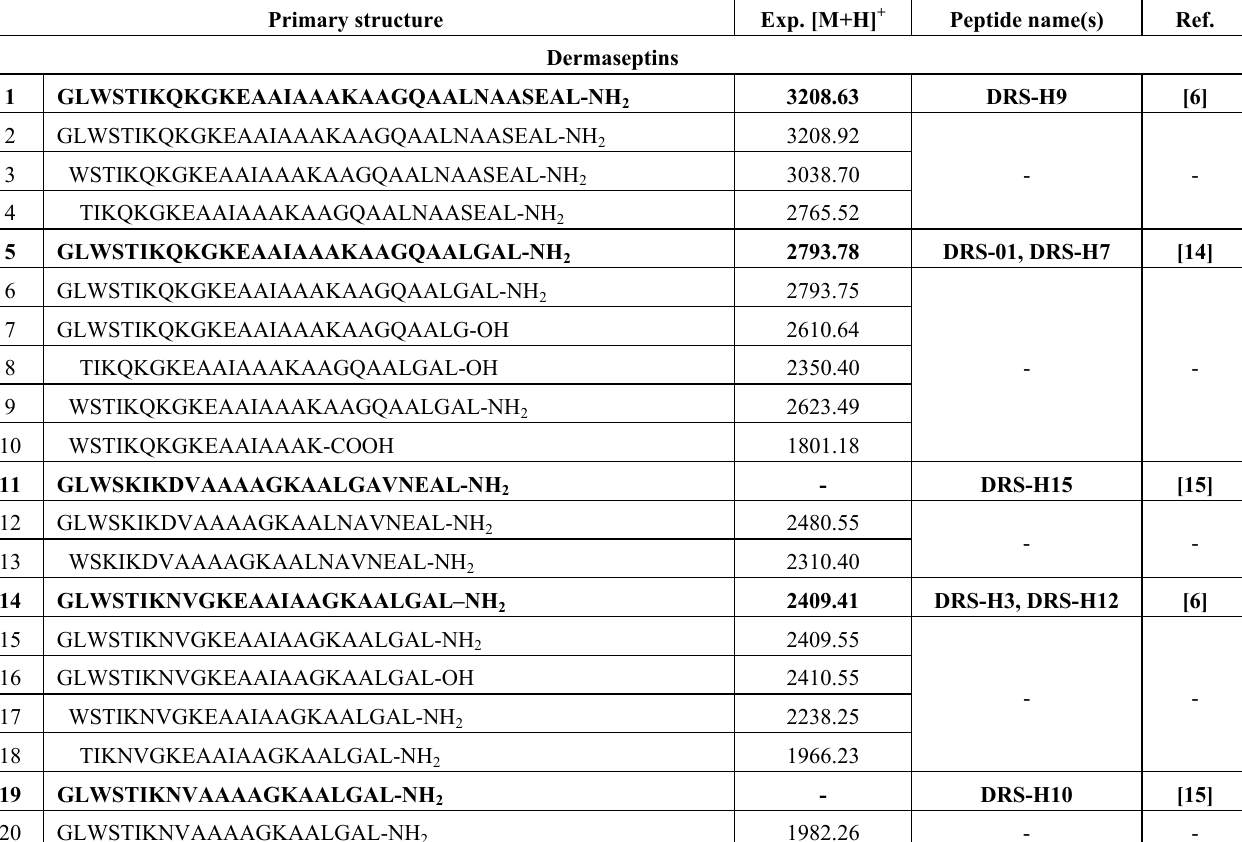
Table 1. Dermaseptins, phylloseptins and hyposins isolated from the skin secretion of P. nordestina . Primary